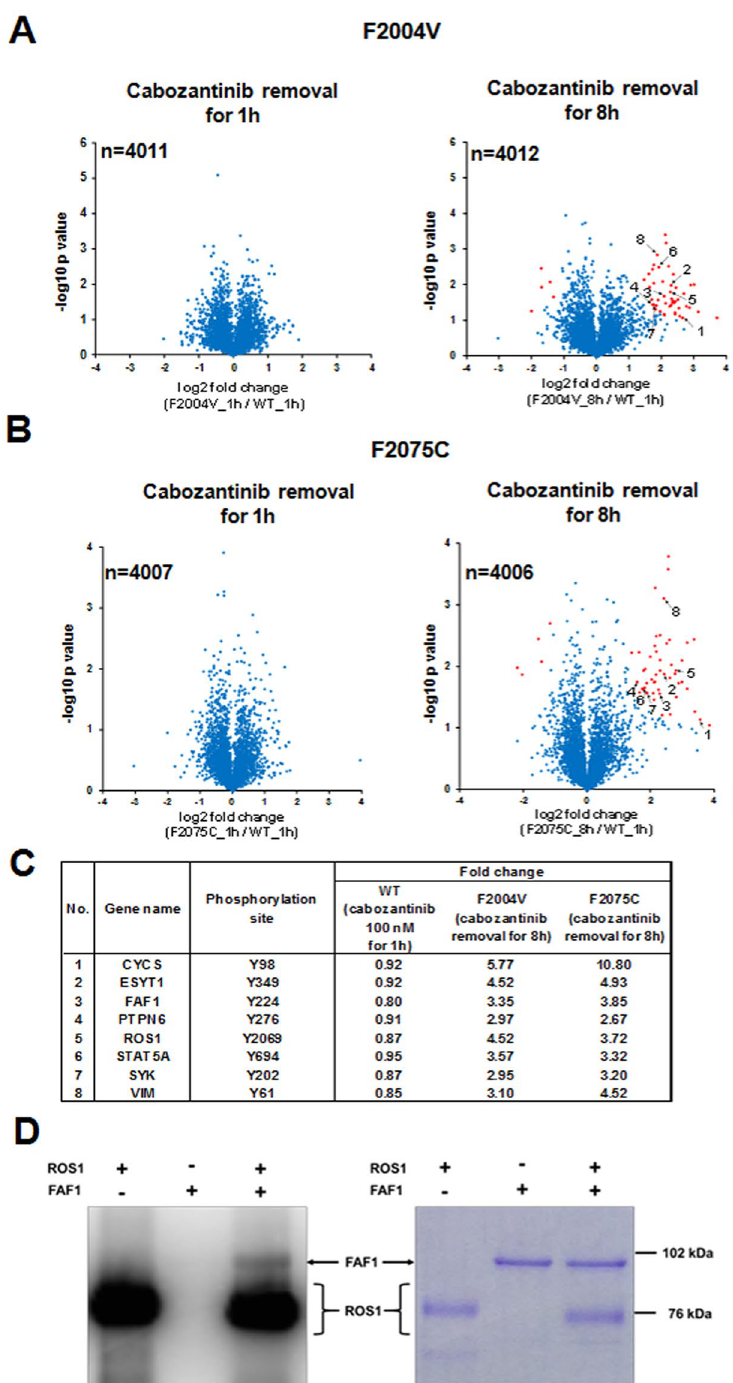
Figure 5. Identification of phosphoproteins phosphorylated by excessive ROS1 signaling. ( A , B ) Volcano plot indicates log2-fold-change in values (horizontal axis) of phosphopeptides in F2004V- or F2075C-mutated cells without cabozantinib and cabozantinib-treated (100 nM) wild-type CD74-ROS1 cells, against the − log10 p value (vertical axis). These plots indicate the log2 fold-change between upregulated or downregulated phosphopeptides in F2004V- ( A ) or F2075C- ( B ) mutated cells by cabozantinib removal (F2004V or F2075C cells without/with 10 nM cabozantinib, respectively) and upregulated or downregulated phosphopeptides in wild-type CD74-ROS1 cell (untreated/cabozantinib-treated). Each plot is based on the mean fold-change of value and the p value of two independent experiments. Plots which passed the 0.05-Benjamini-Hochberg-false discovery rate threshold are shown in red. ( C ) List of representative common phosphopeptides which were significantly upregulated in the F2004V- or F2075C-mutated cells after removal of cabozantinib. ( D ) Coomassie brilliant blue-stained gel (right) and autoradiography (left) of human ROS1 and FAF1 proteins electrophoresed with [gamma- 32 P] ATP. Uncropped gel and autoradiograph are presented in Supplementary Fig.